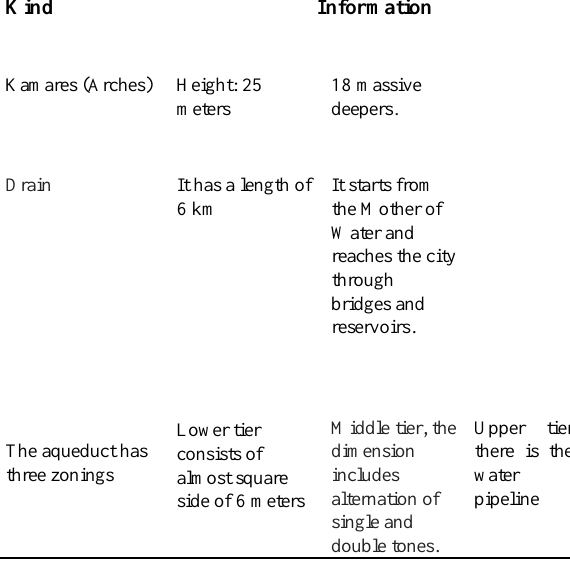
Table 2 . Characteristics of Aqueduct